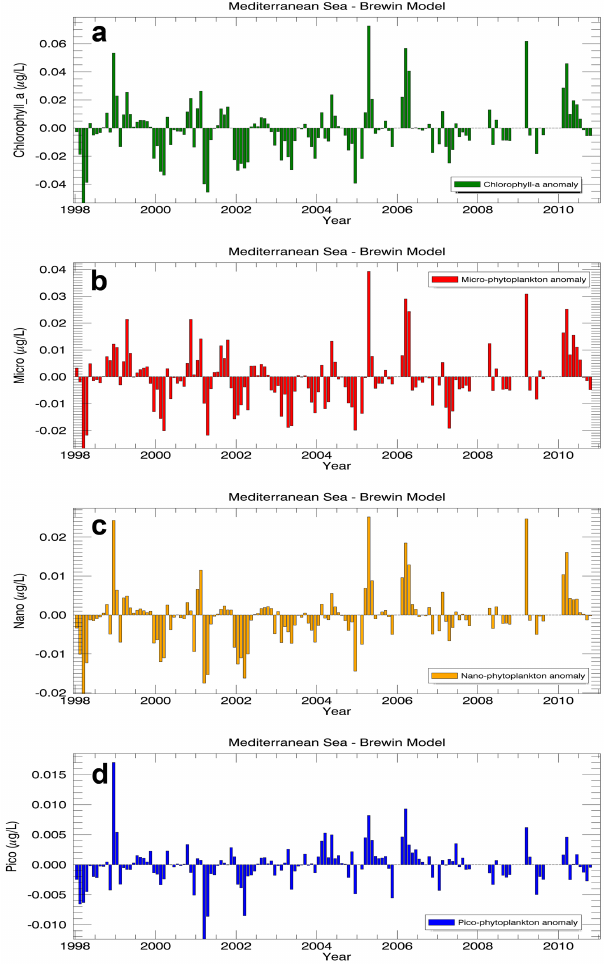
Figure 9. Inter-annual variability of the contribution of micro-, nano- and pico-phytoplankton to the TChl a (µgL − 1 ) from 1998 to 2010 in the four sectors: Northwestern Mediterranean Sea (a) , Levantine Sea (b) , Alborán Sea (c) , and North Adriatic Sea (d) . Gaps in the time series correspond to months where less than 90% of observations were recorded in the